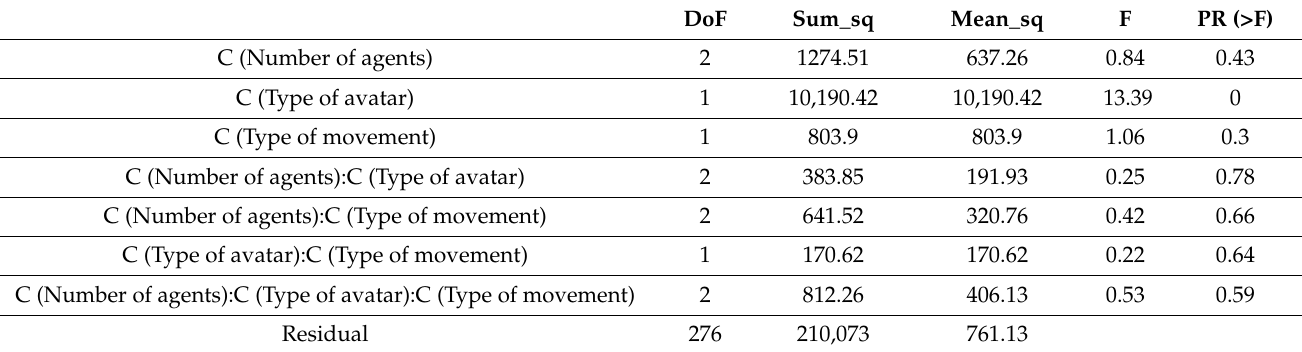
Table 3. Three-way ANOVA for vertical movement on time